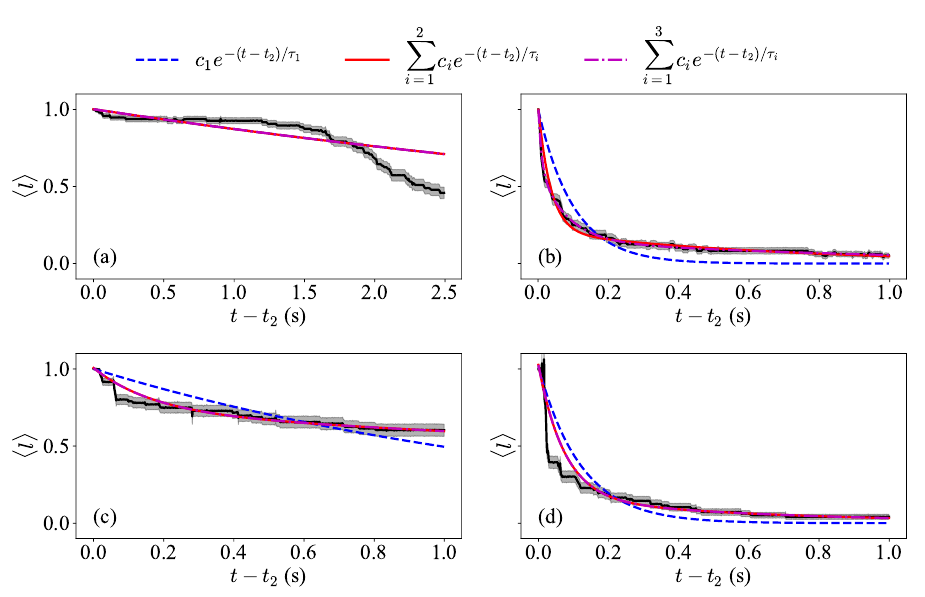
Figure 16: Multi-parameter fits of the average winding number (solid black line) dur- ing the period where the barrier is held at its maximum ( t is the time the barrier first 2 reaches maximum height). Fitting functions are shown at the top of the figure, with } . The subfigures refer to four different temperatures and fitting parameters { c , τ i i = 0.7 µ ; (b) T = 40nK, V = 0.74 µ ; (c) T = 85nK, barrier heights: (a) T = 30nK, V b b = 0.76 µ ; and (d) T = 195nK, V = 0.77 µ . The grey shaded region gives a 95% V b b confidence interval of the average winding number 〈 l 〉 . In general, the two-timescale fit (red solid line) is sufficient, with the exception of the highly-nonexponential trend in